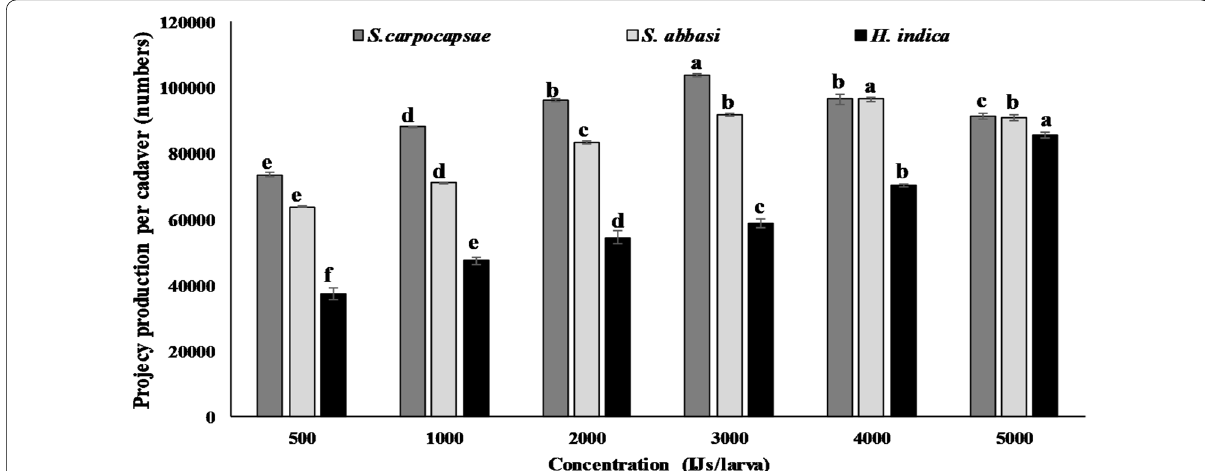
Fig. 2 Progeny production by grubs of Oryctes. rhinoceros exposed to different concentration of infective juveniles (IJs) of Entomopathogenic nematodes (EPNs): Steinernema. carpocapsae, S. abbasi and Heterorhabditis indica . In a bar column with different alphabet letter were significantly different at Tukey’s HSD at P =